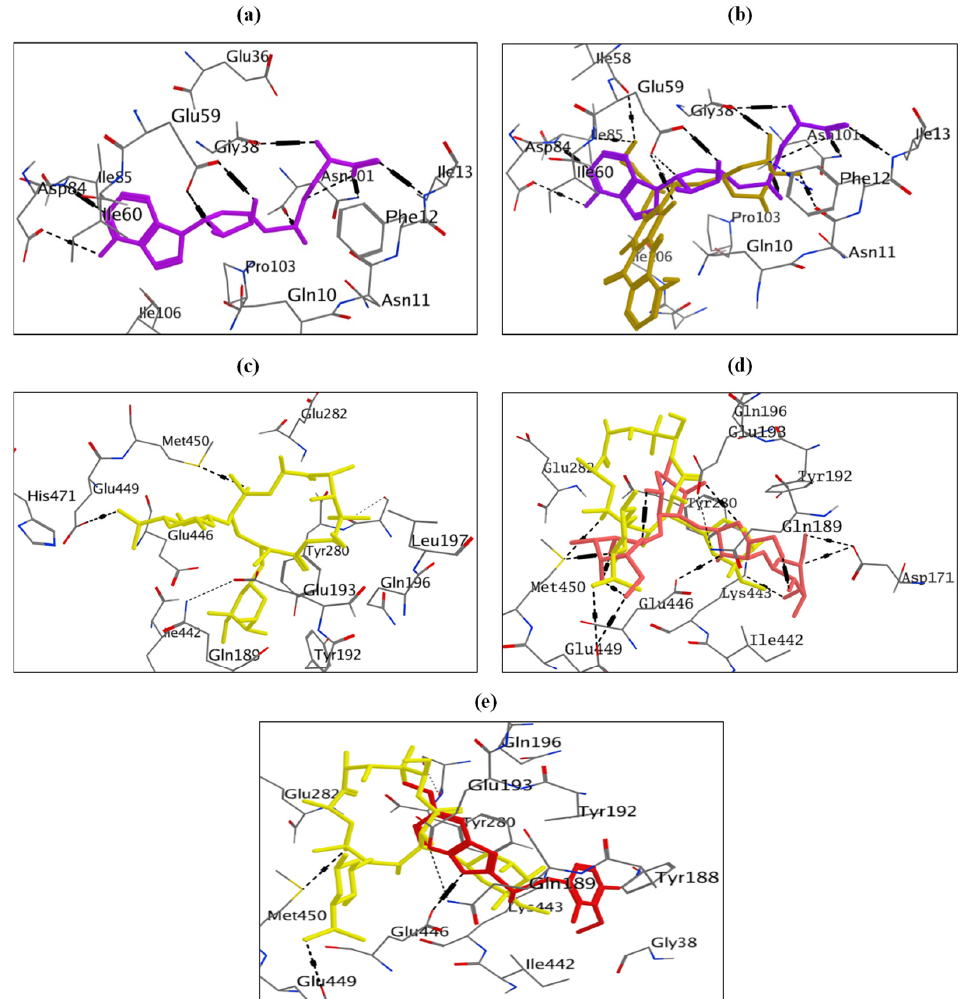
Figure 5. The molecular docking results of sinefungin (SFG) and doxorubicin at S-adenosyl-L-methionine (SAM) binding site of ErmC’ protein, and erythromycin, neomycin, and omeprazole at MsrA protein. ( a ) 3D interaction of SFG (violet) at SAM-binding site of ErmC’. ( b ) 3D diagram of overlay view of doxorubicin (dark yellow) and SFG (violet) at SAM-binding site of ErmC’. ( c ) 3D representation of erythromycin (yellow) at active site of MsrA protein. ( d ) 3D representation of overlay view of neomycin (dark pink), erythromycin (yellow) at active site of MsrA protein. ( e ) 3D representation of overlay view of omeprazole (red) and erythromycin (yellow) at active site of MsrA protein. For clarity, non-interacting residues were deleted. Hydrogen bonds are shown in black, and arene hydrogen bonds are shown in dark blue (UniProtKB ID: Q9ZNK9).